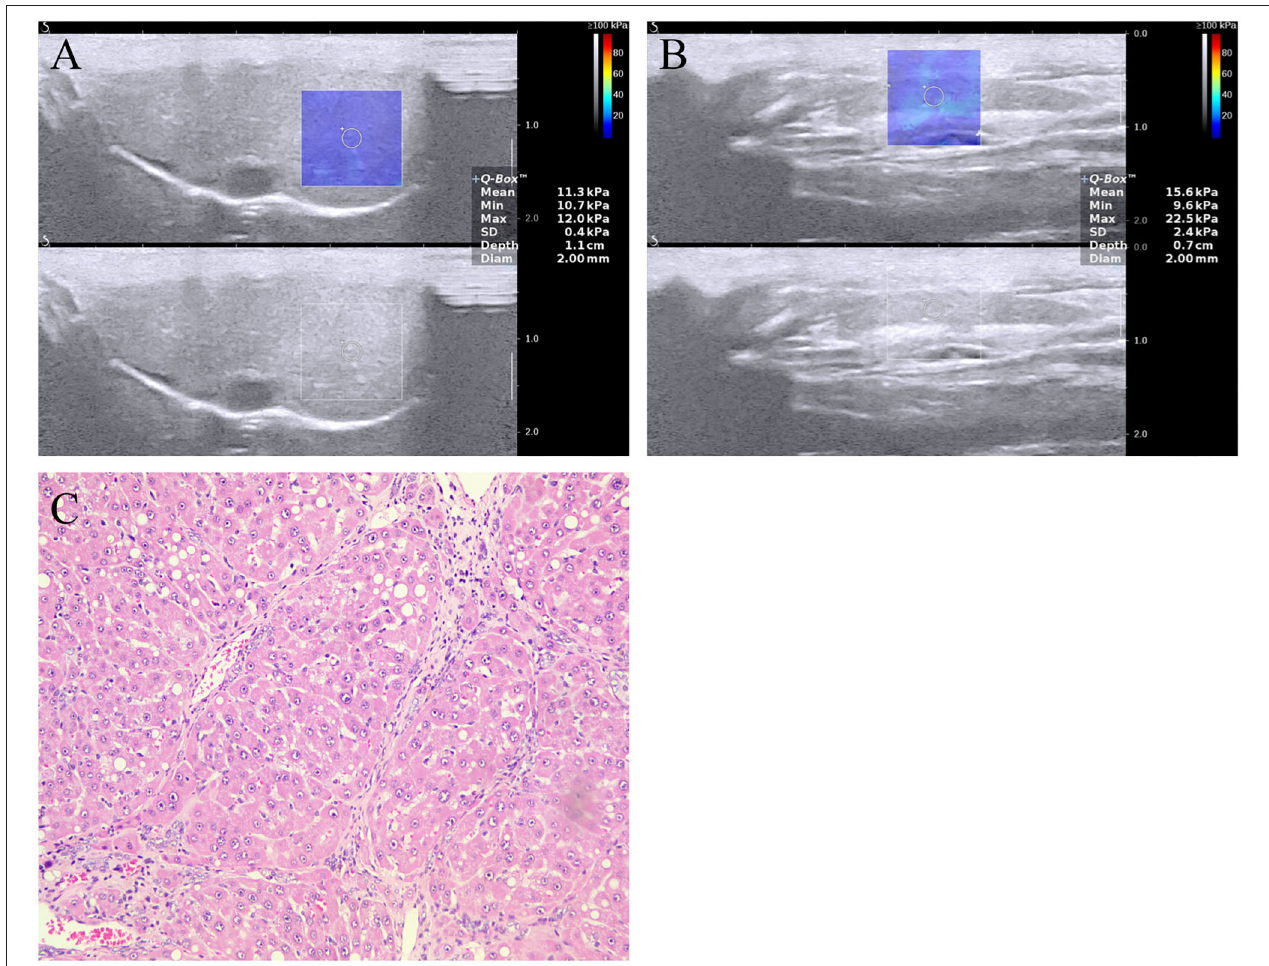
FIGURE 1 | Two-dimensional shear wave elastography (2D-SWE) measurement of the (A) liver and (B) spleen, and (C) image of liver section stained with hematoxylin and eosin in a rat model with NAFLD. The mean LSM and SSM were 11.3 ± 0.4 and 15.6 ± 0.7 kPa, respectively. The image of liver section revealing fibrosis stage F4 (cirrhosis). LSM, liver stiffness measurement; NAFLD, nonalcoholic fatty liver disease; SSM, spleen stiffness measurement.